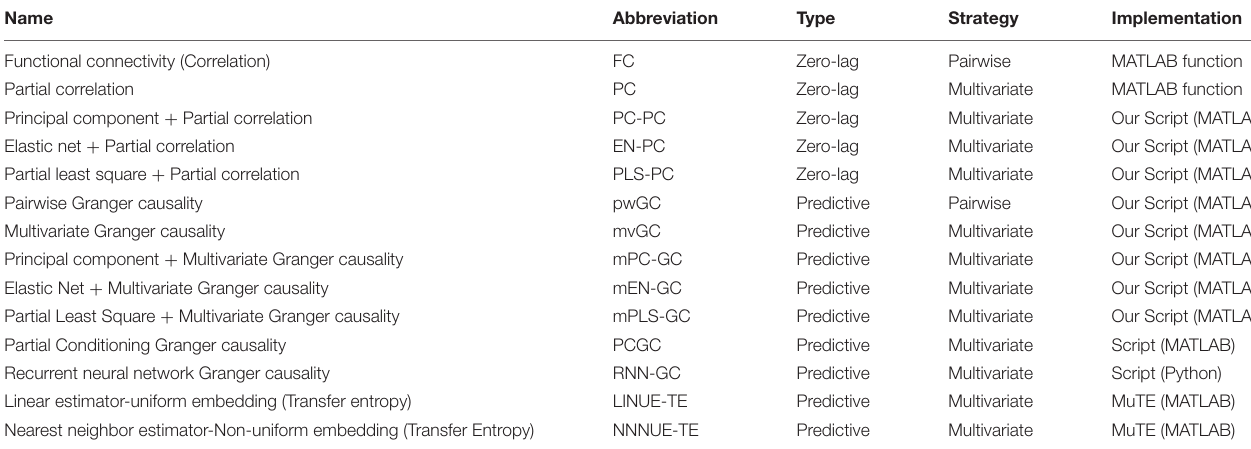
TABLE 1 | Comparison